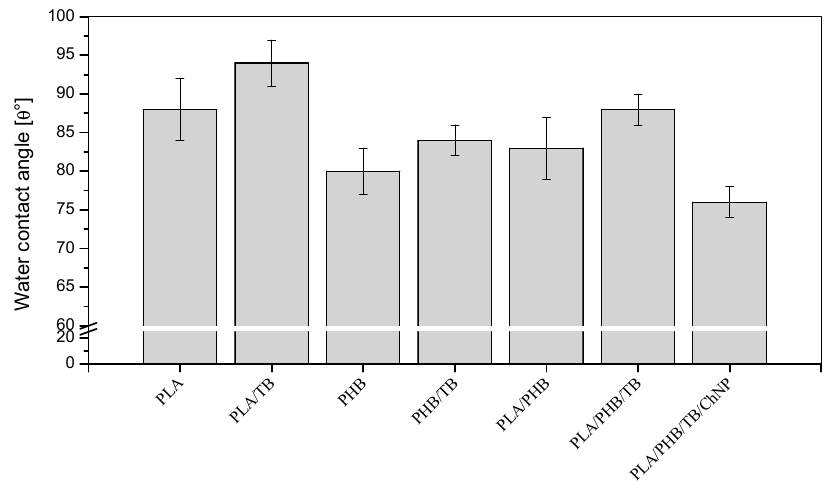
Figure 7. Contact angle measurements of PLA- and PHB-based materials.